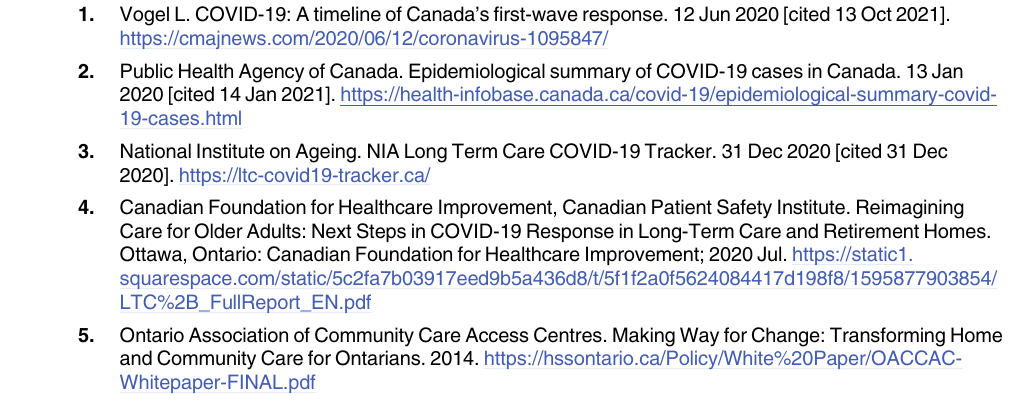
S1 Fig. Sample flow diagram. S1 Table. Parameter estimates from regression